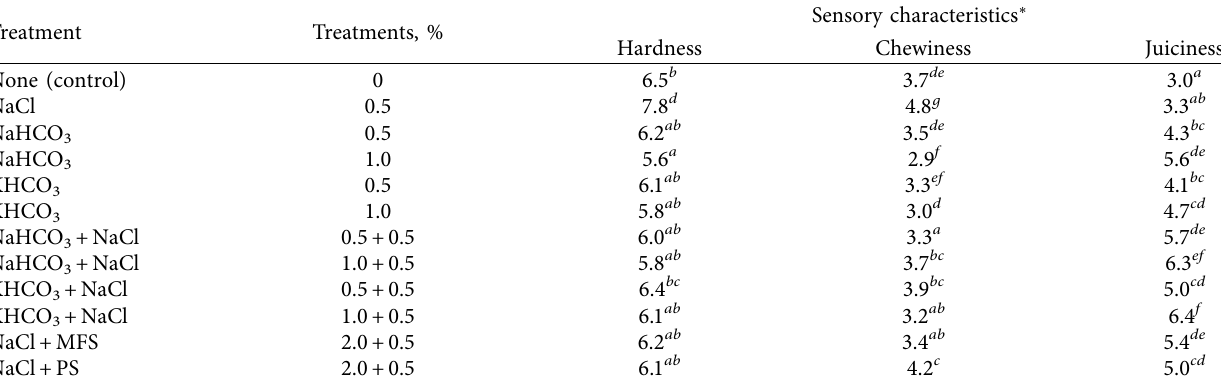
Table 5: Least-squares means for sensory descriptive hedonic scores of cooked ground beef treated with different levels of sodium bi- carbonate, potassium bicarbonate, salt, modified food starch, and potato